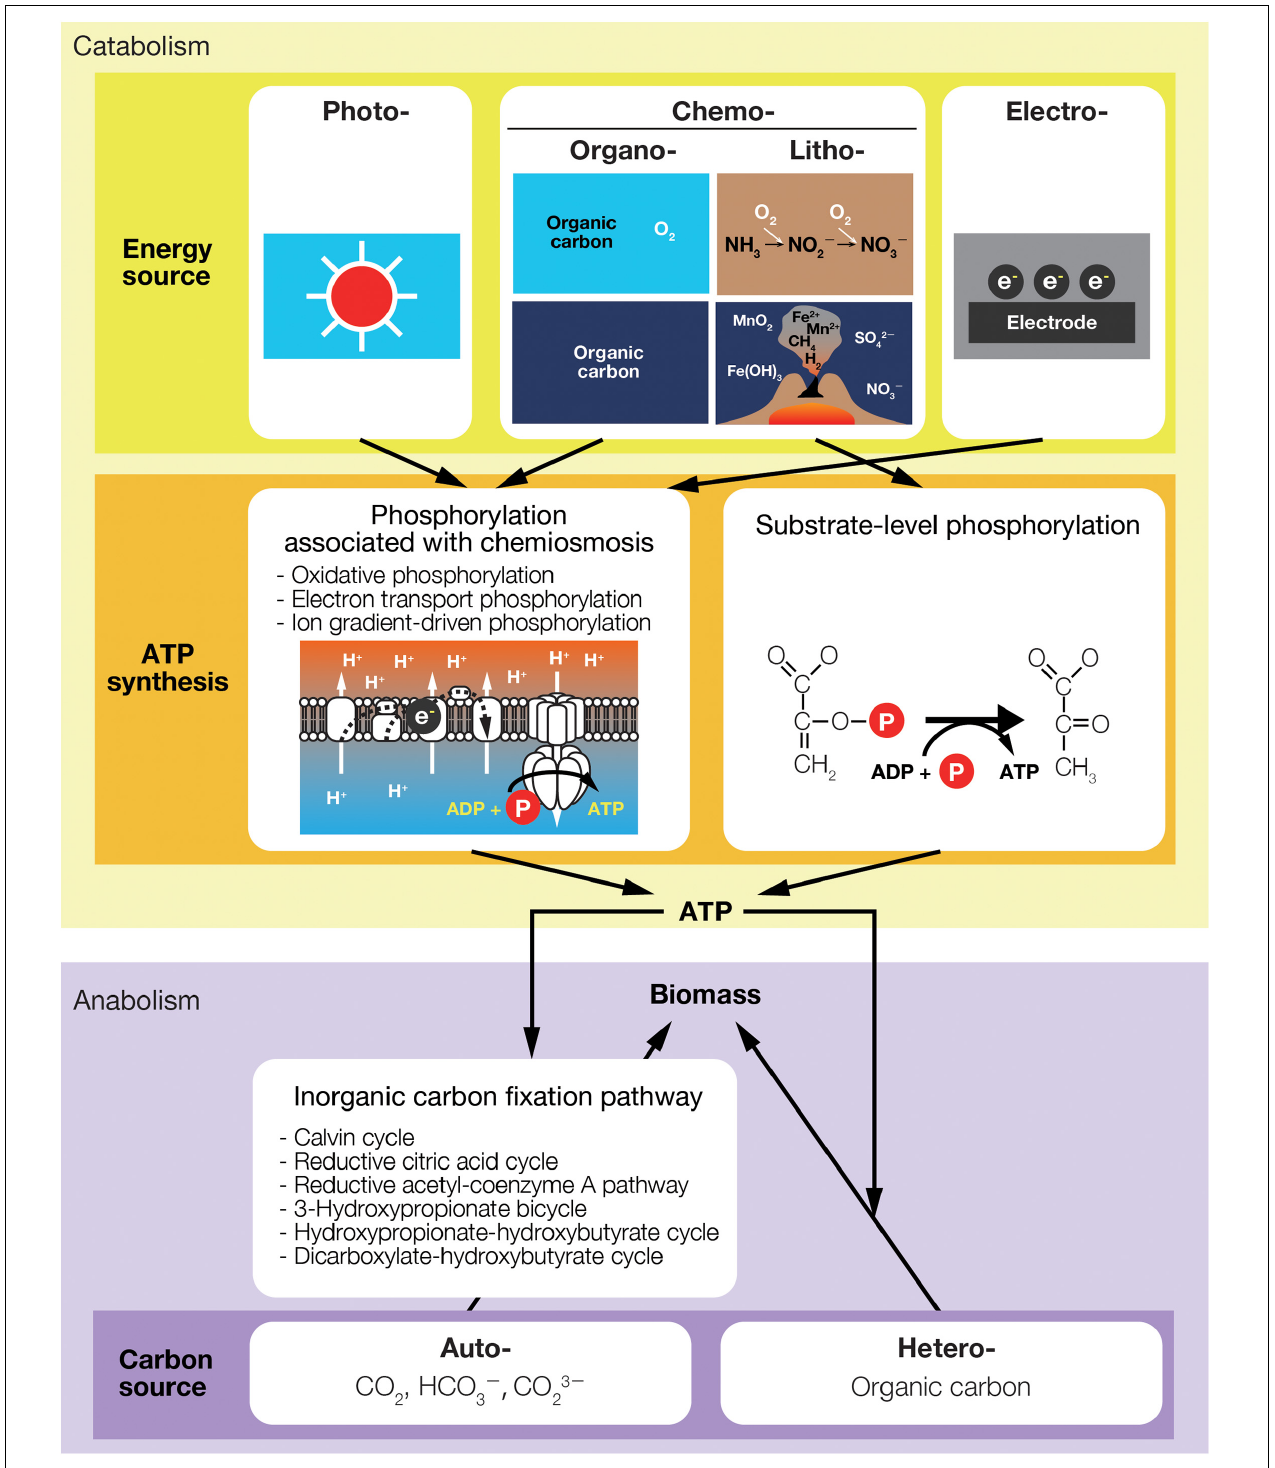
FIGURE 1 | Primary nutritional groups and types of energy sources, ATP synthesis, and carbon sources for life. The names of primary nutritional groups are built by combining the Greek terms meaning the direct source of energy [photo (light), chemo (chemical), or electro (electric)] and carbon [auto (using inorganic carbon) or hetero (using organic carbon)] and “troph(s)” meaning nourishment. Chemo-(auto or hetero)-trophs that use organic carbon for energy-source reactions (e.g., aerobic respirators and fermentation bacteria) are especially termed chemo-organo-(auto or hetero)-trophs and others that only use inorganic substances for energy-source reactions (e.g., the reactions listed in Table 1 ) are termed chemo-litho-(auto or hetero)-trophs.